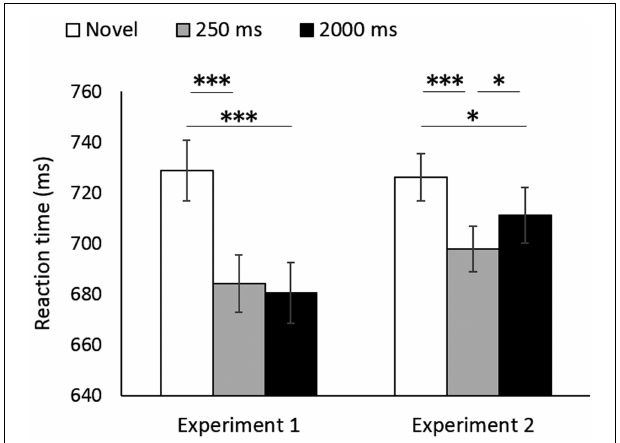
FIGURE 1 | Mean reaction time in each condition. Error bars indicate the 95% within-participant confidence interval (Baguley, 2012). *** p < 0.001, * p <